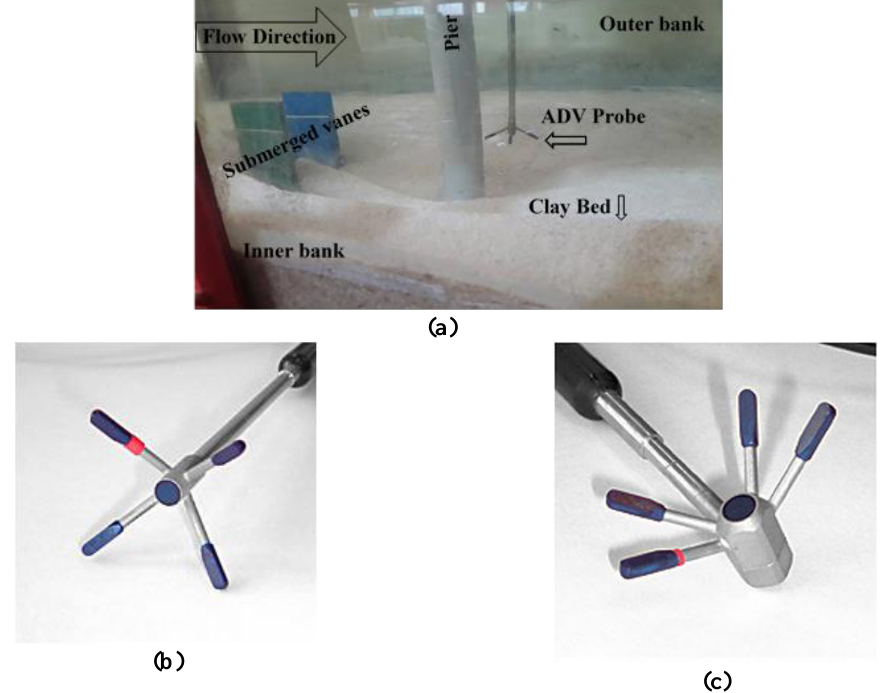
Figure 2. a) the position of Vectrino velocimeter in the 180 degree sharp bend, and a view of